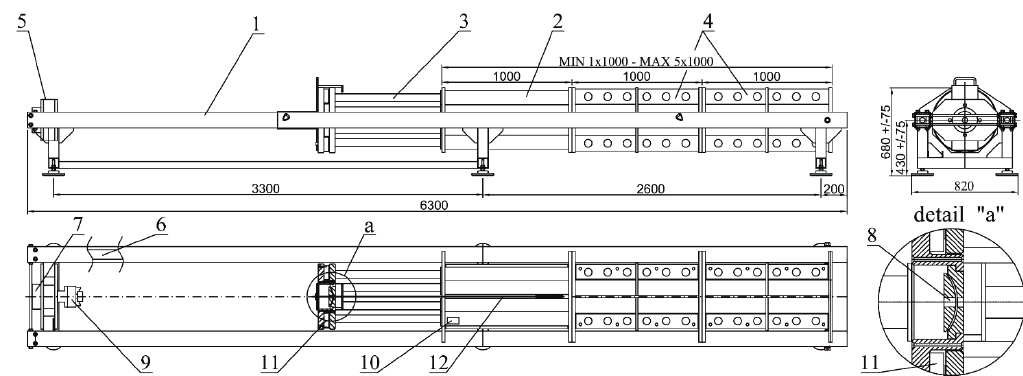
Fig. 4. Test rig for rock bolt loading tests; 1 – 11 support; 2 – block with hydraulic jacks; 3 – hydraulic jack; 4 – bushings; 5 – engine’s traverse; 6 – hydraulic jack; 7 – engine; 8 – washer; 9 – triple shank; 10 – displacement sensor; 11 – force sensors; 12 – rock